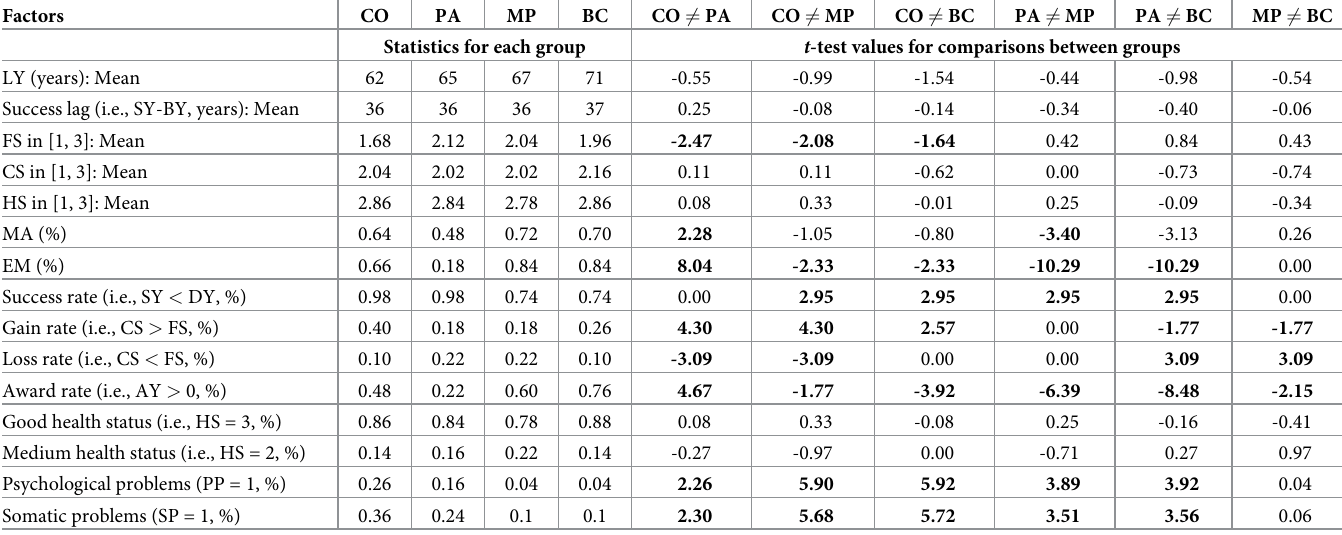
Table 1. The descriptive statistics for the sample of 200